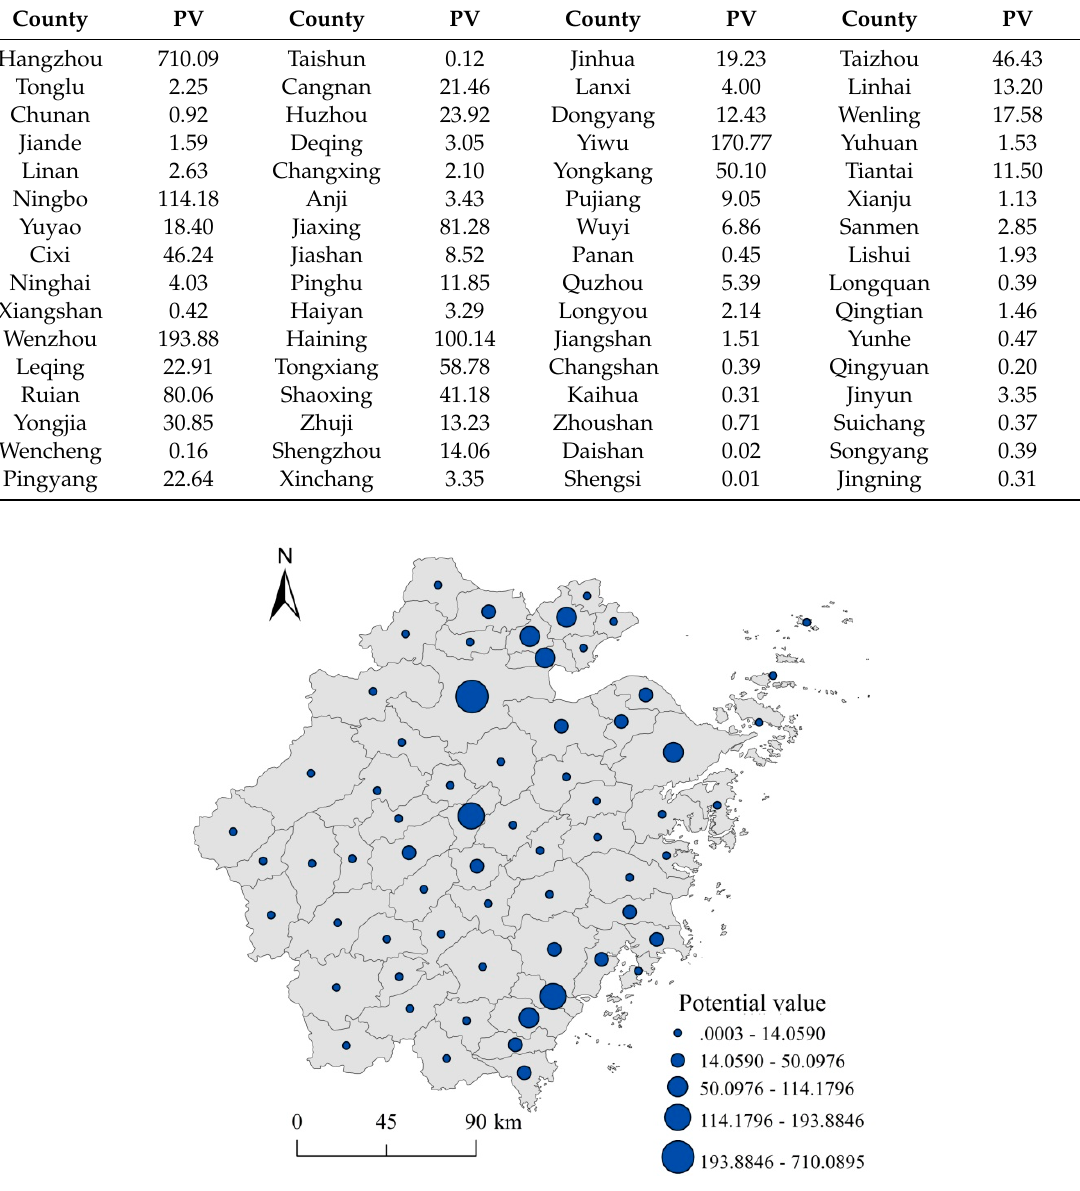
Figure 2. Spatial distribution of the potential value of the e-retail economy in Zhejiang Province.